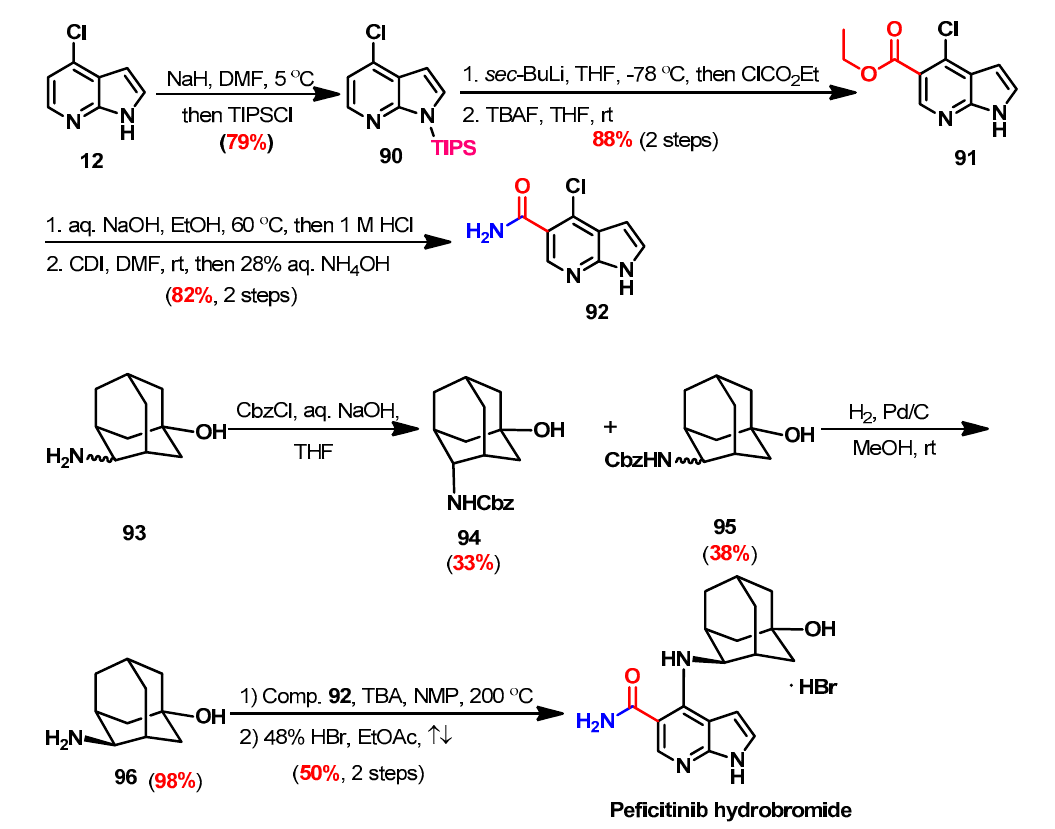
Scheme 11. Synthesis of peficitinib.